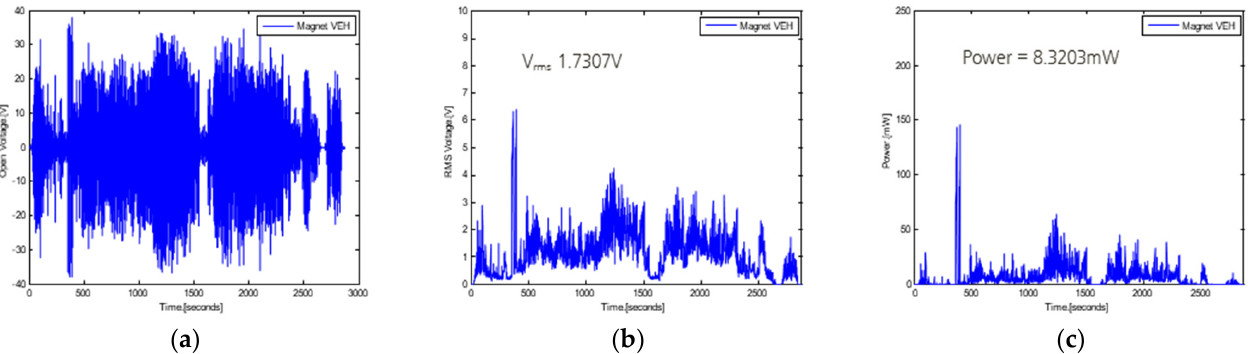
Figure 15. Performance test results of the magnet vibration ‐ energy ‐ harvesting (VEH) device, a 45 ‐ Hz resonance frequency, and a 360 ‐Ω load resistance: ( a ) peak ‐ to ‐ peak voltage (V pk ‐ pk ‐ veh ‐ T ); ( b ) root mean square (RMS) generated voltages (V rms ‐ veh ‐ T ); ( c ) experimentally generated power (P exp ‐ veh ‐ T ).